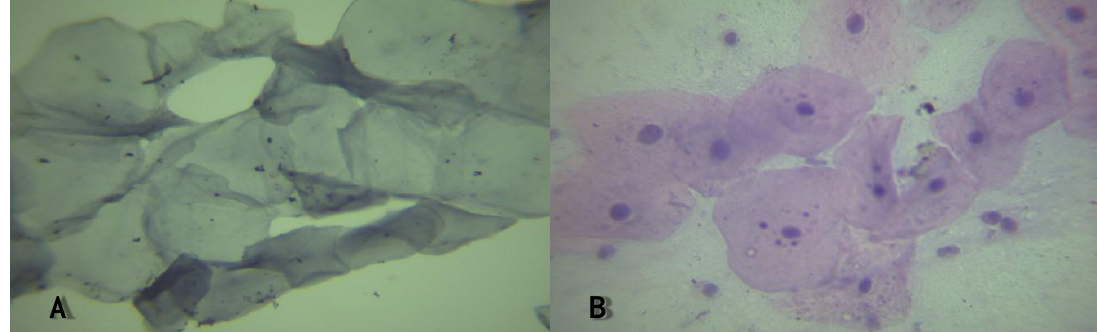
Fig 1. Comparison of Feulgen Stained Slides (A) With Hematoxylin-eosin staining after Routine Feulgen Staining Technique